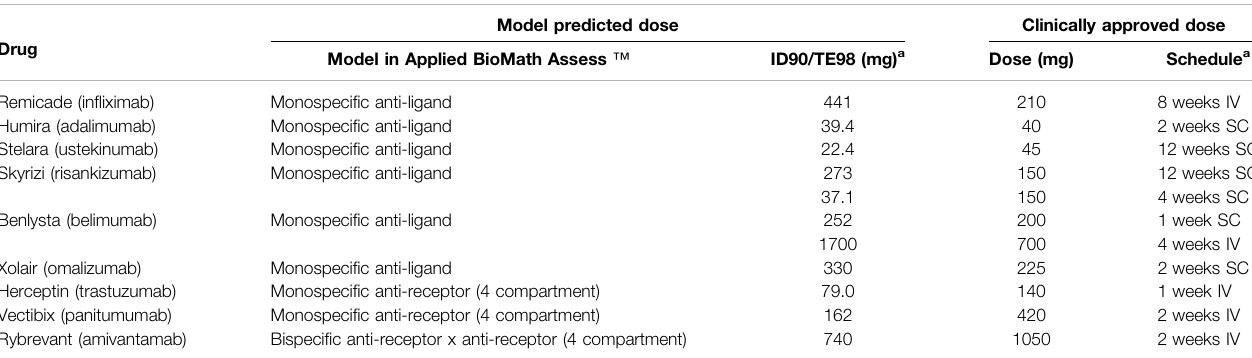
TABLE 5 | Effective dose predictions for a panel of